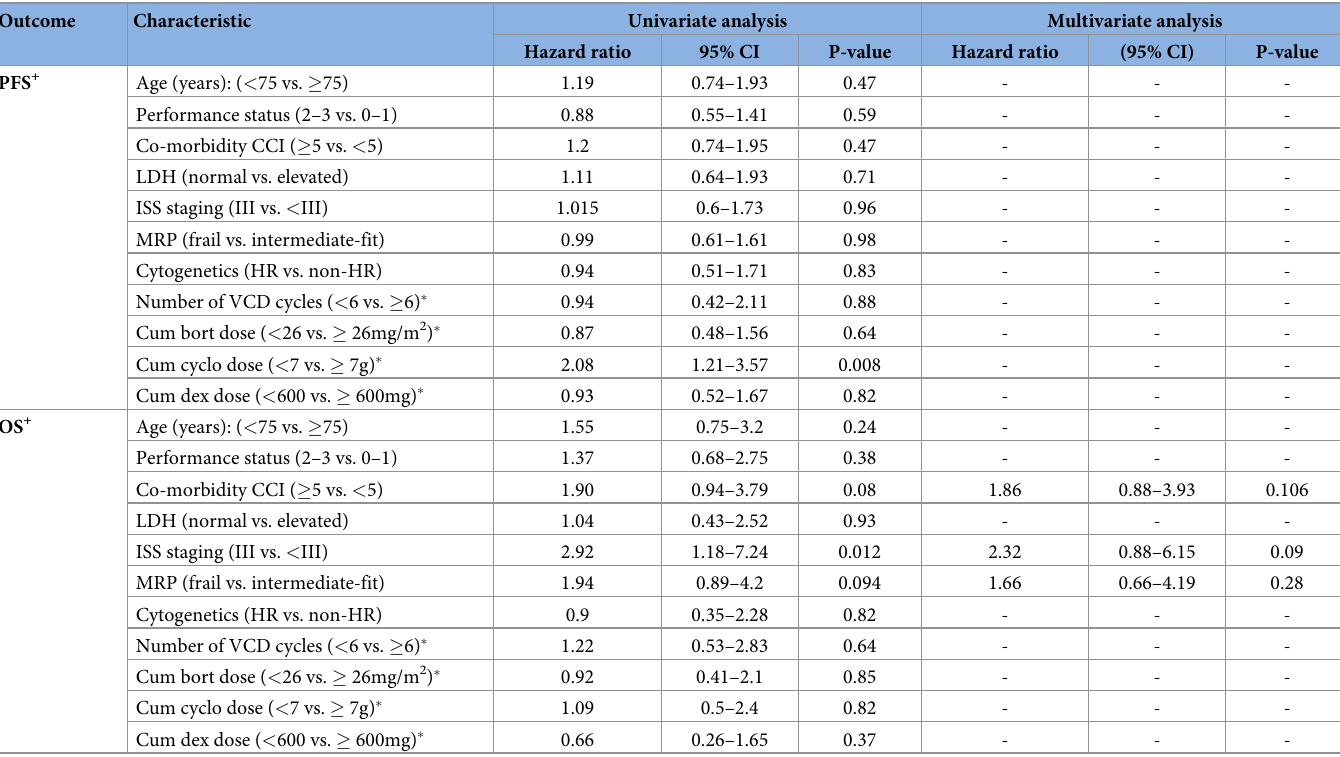
Table 4. Univariate (UVA) and multivariate (MVA) analyses for PFS and OS. Outcome